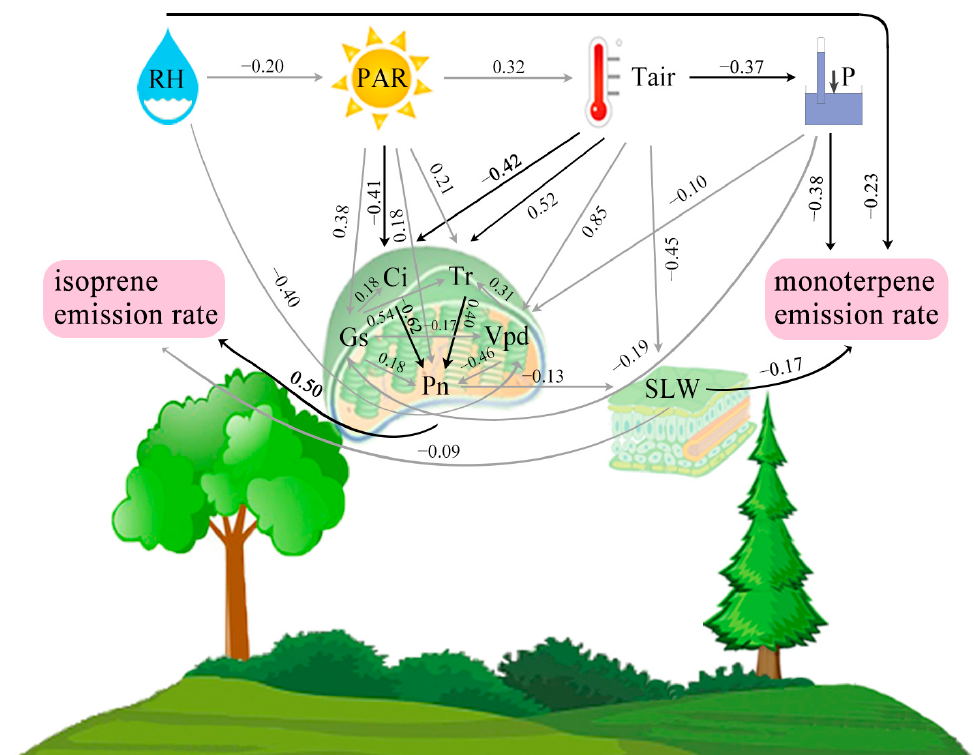
Figure 6. PA model among the environmental factors (PAR: photosynthetically active radiation; P: atmospheric pressure; Tair: air temperature; RH: relative air humidity), plant eco-physiological factors (SLW: specific leaf weight; Pn: photosynthetic rate; Tr: transpiration rate; Gs: stomatal conductance; Ci: intercellular CO 2 concentration; Vpd: vapour pressure deficit) and the emission rates of isoprene and monoterpenes. Standard coefficients are shown on each line. The black lines indicate the major pathways affecting the emission rates of isoprene and monoterpenes.